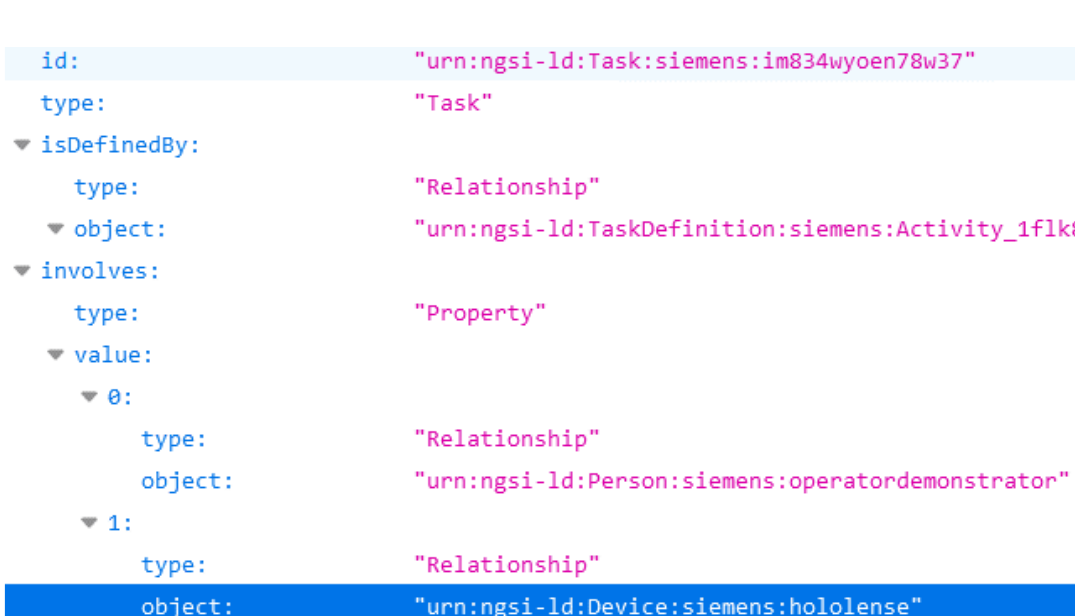
Figure 2. ARContent editor: main screen.